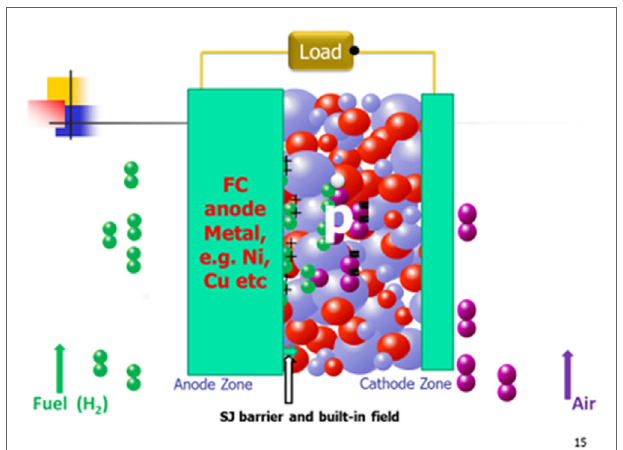
FiGURe 9 | p–n junction type eFFC working principle (black ball: e − charge; white ball: hole charge; green ball + : H + ; purple ball = : O 2 = ; blue and red balls simply semiconductor-ionic material)